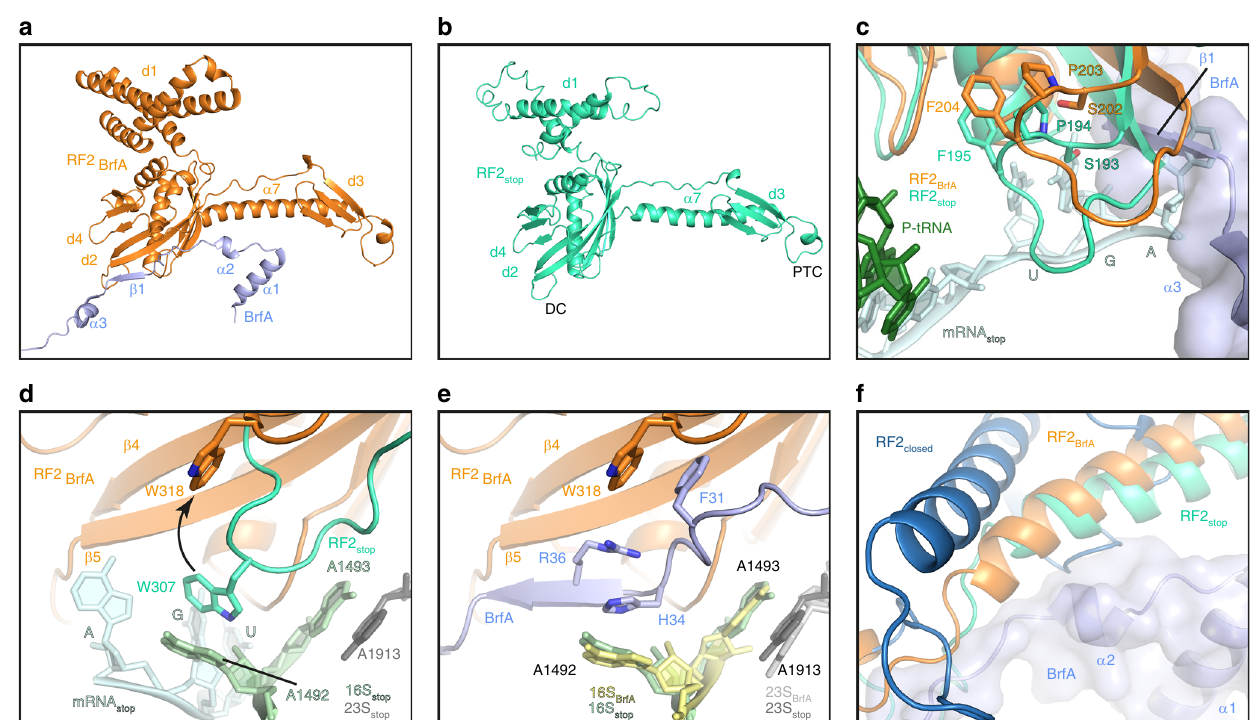
Fig. 5 BrfA recruits and stabilizes the open conformation of RF2 on the ribosome. a , b Overview of the interaction of BrfA (blue) with ( a ) RF2 (RF2 BrfA , orange) from the BrfA-RF2-ns70S and with ( b ) RF2 (RF2 stop , lime, PDB ID 4V5E) from a canonical termination complex 48 . RF2 domains 1 – 4 (d1 – d4) and relative positions of the decoding center (DC) and peptidyltransferase center (PTC) are indicated. c Comparison of the relative positions of the SPF motif of RF2 stop (lime) and RF2 BrfA (orange) with BrfA (blue), P-site tRNA (green), and truncated non-stop mRNA (TR-mRNA, cyan) shown for reference. d Interaction between Trp307 (W307, equivalent to B. subtilis Trp318 (W318)) of the switch region of Thermus thermophilus RF2 stop (lime) and A1492 of the 16S rRNA (green) during decoding of the UGA stop codon of the mRNA (cyan). W318 in the switch loop of B. subtilis RF2 (RF2 BrfA , orange) observed upon BrfA binding is superimposed and arrowed. e Same view as in d , but showing the conformation of the switch loop of RF2 BrfA (orange) and A1492/A1493 (yellow) when BrfA (blue) is present. f Superimposition of the conformation of α -helix α 7 of RF2 from the crystal structure of the closed form of RF2 (RF2 closed ; dark blue, PDB ID 1GQE) with RF2 stop (lime) and RF2 BrfA (orange), with BrfA (blue) shown for